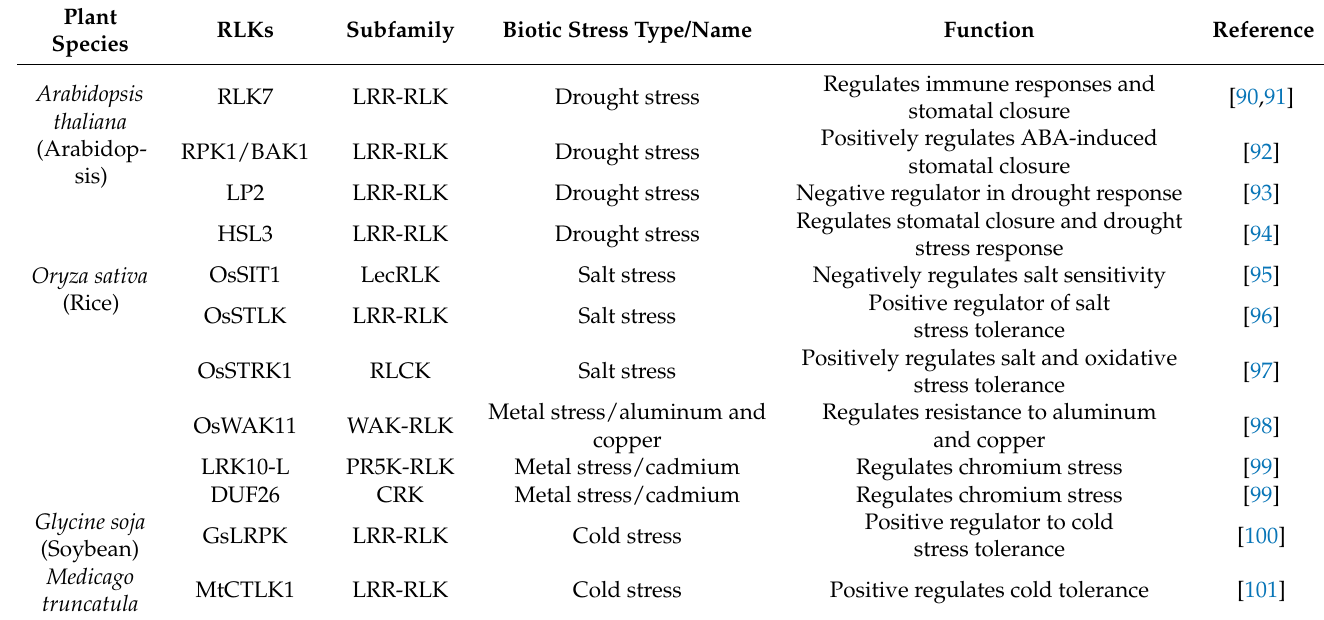
Table 4. RLKs involved in abiotic stress response and their